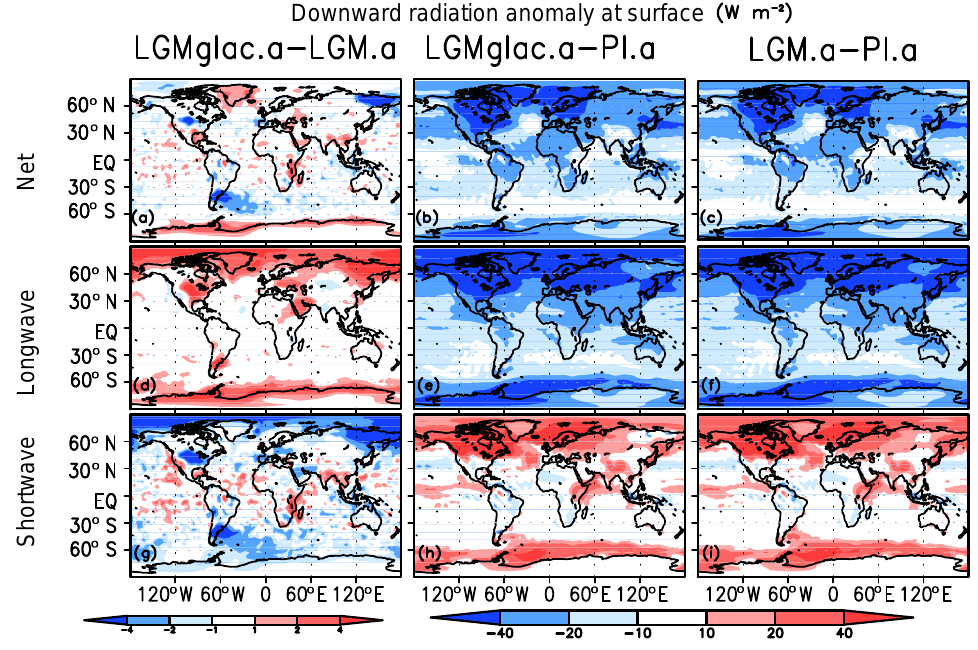
Figure 7. Change in (a) net, (d) longwave, and (g) shortwave downward radiation at the surface for LGMglac.a–LGM.a (Wm − 2 ) (down- ward, positive). The same in (b) , (e) , and (h) for LGMglac.a–PI.a and (c) , (f) , and (i) for